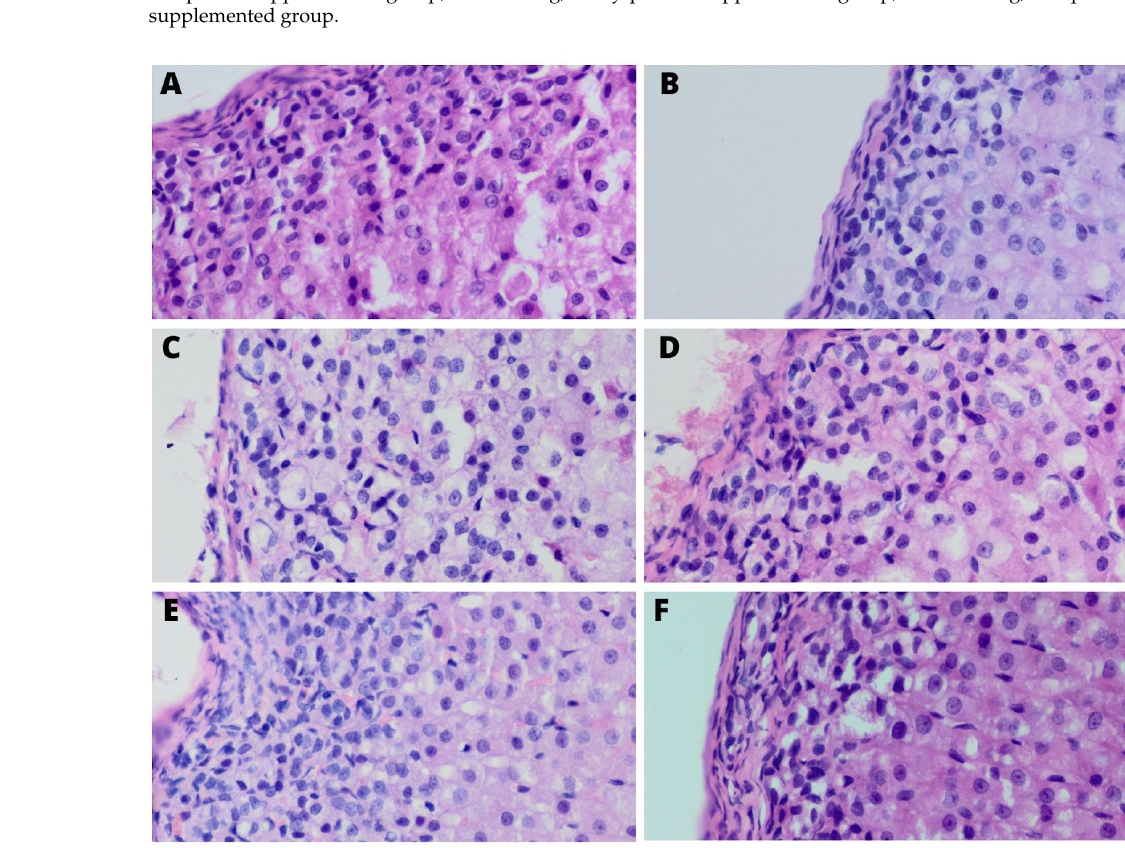
Figure 2. Adrenal glands 400x magnified; non-running control group ( A ); running control group ( B ); non-running whey-protein-supplemented group ( C ); non-running bee-pollen-supplemented group ( D ); running whey-protein-supplemented group ( E ); running bee-pollen-supplemented group ( F ). Visible decrease in pyknotic nuclei in the non-running experimental groups ( C , D ) in comparison to the non-running control one ( A ). All of the columns show zona glomerulosa and zona fasciculata. H&E staining.